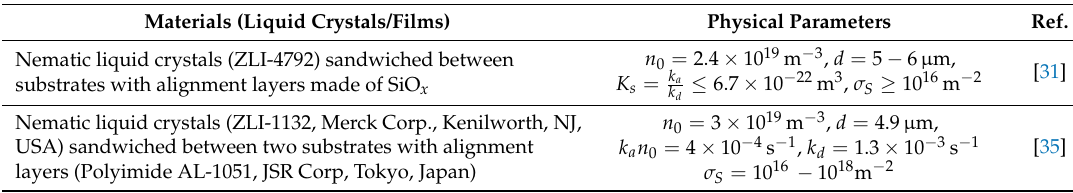
Table 2. Examples of existing experimental data.